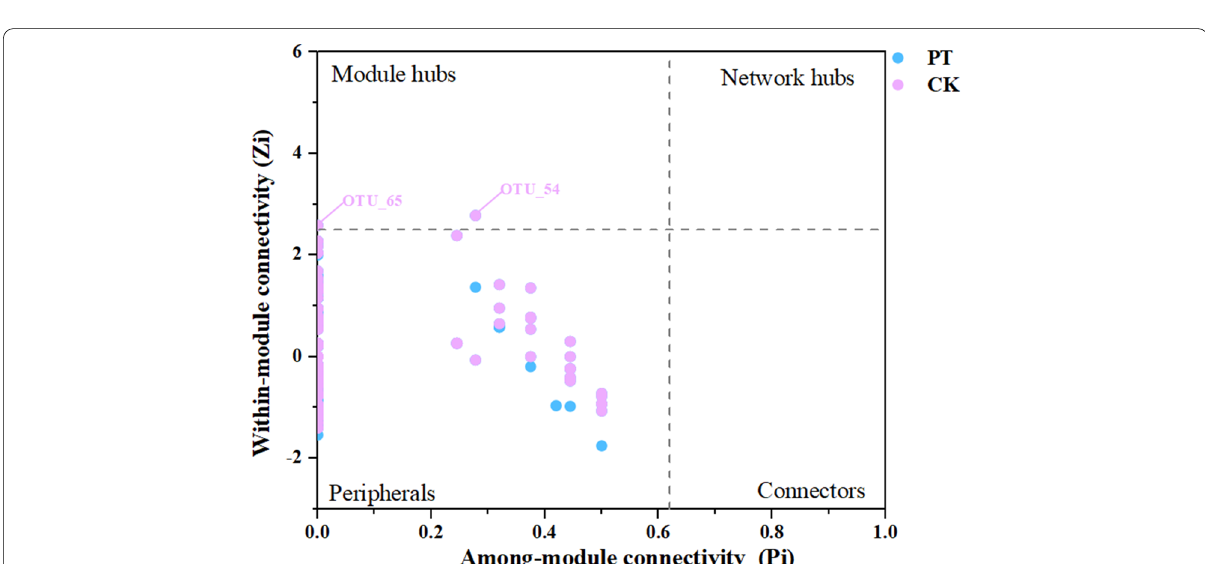
Fig. 6 The Zi-Pi plot exhibited the distribution of bacterial OTUs based on their topological roles. The thresholds for Zi and Pi for classifying OTUs are 2.5 and 0.62,